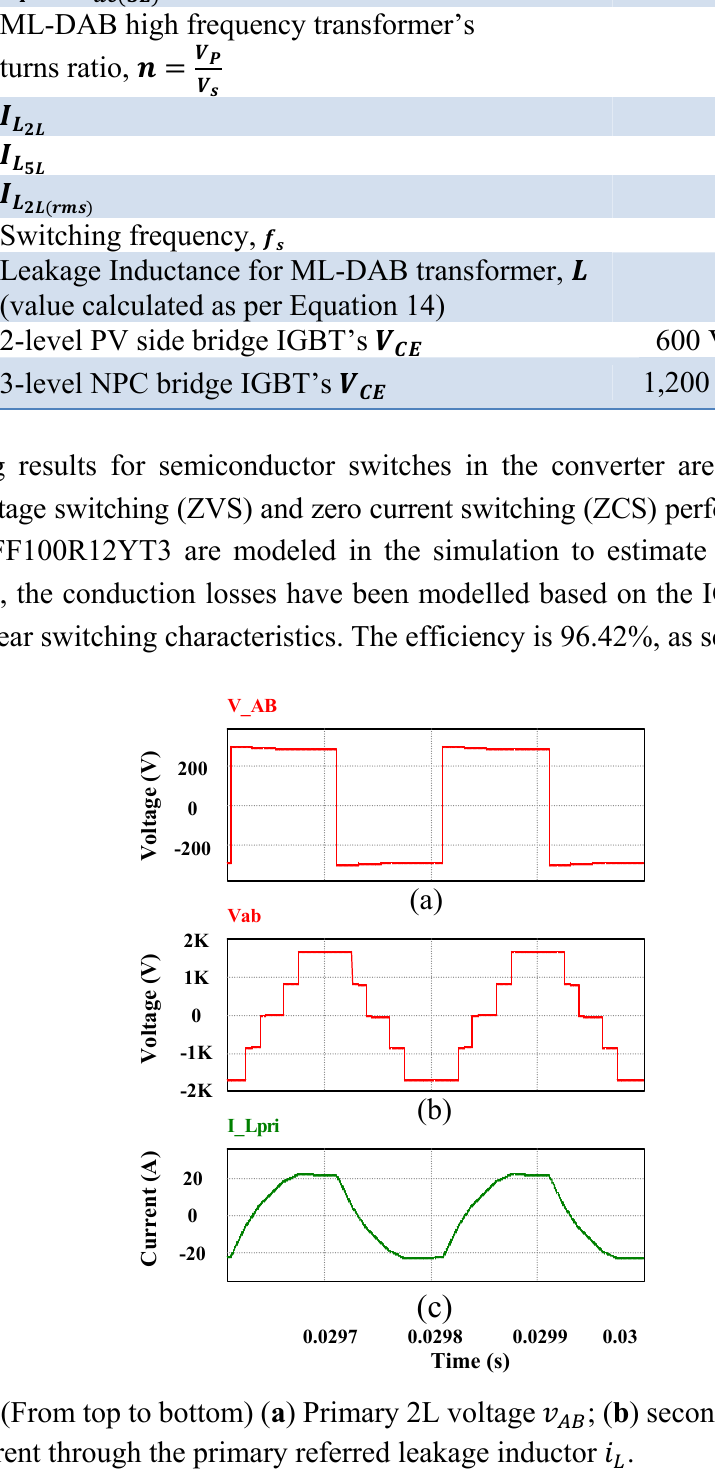
Figure 18. (From top to bottom) ( a ) Primary 2L voltage (cid:1874) and ( c ) current through the primary referred leakage inductor (cid:1861)